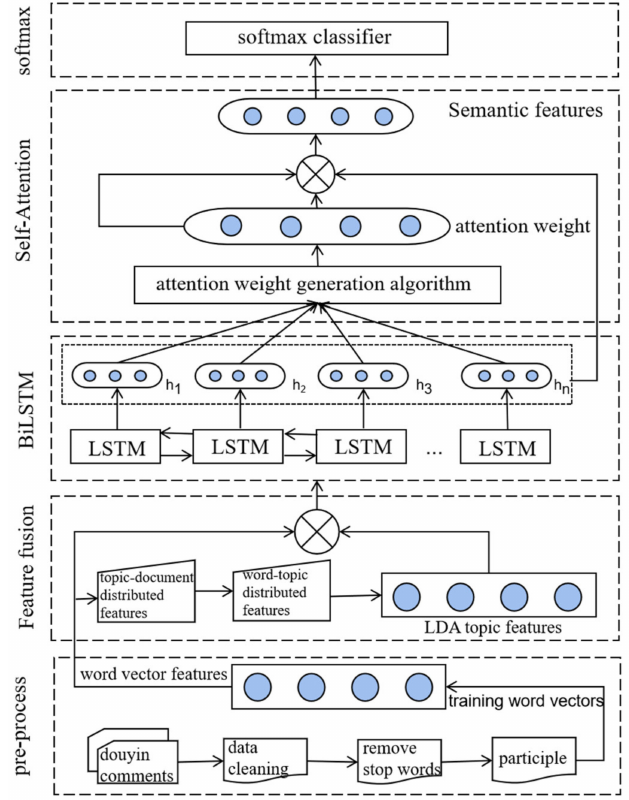
Figure 1. LBSA model structure